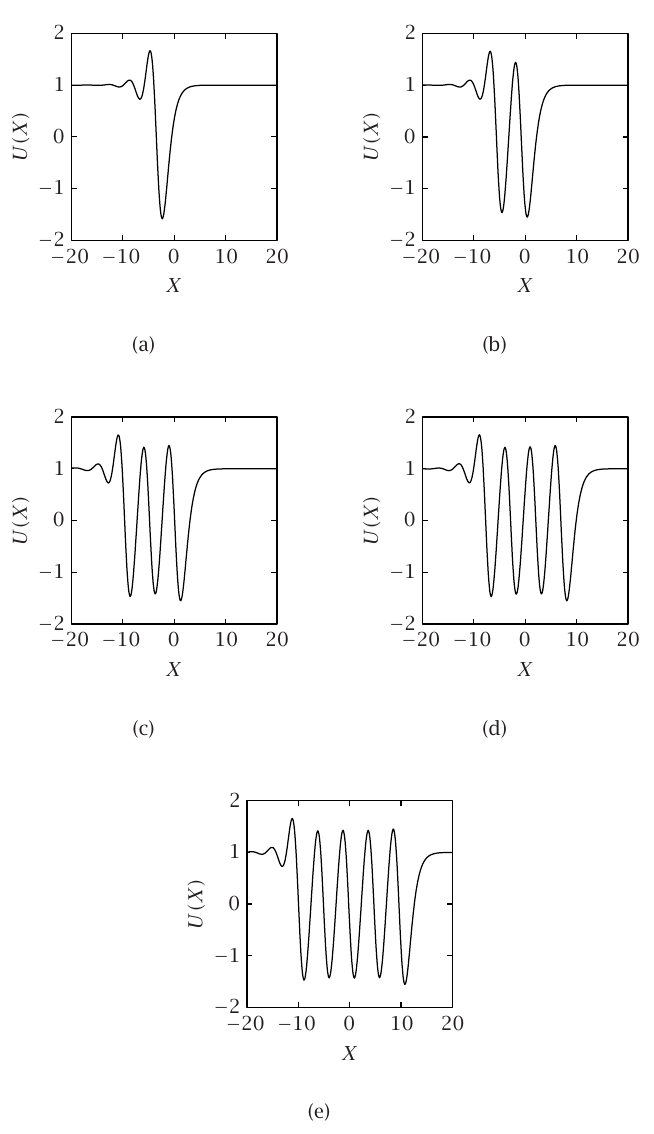
Figure 3.3 . Numerical solutions for the first family of solitary waves: (a) γ = 0 . 36975528, (b) γ = 0 . 34837892, (c) γ = 0 . 34932100, (d) γ = 0 . 34928100, (e) γ = 0 .